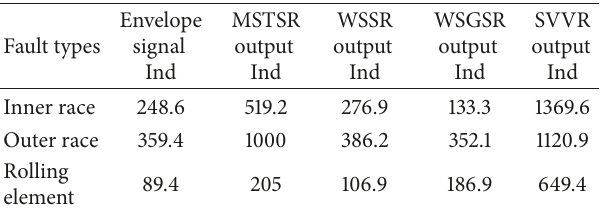
Table 4: Ind’s with various bearing fault types processed by different WSD